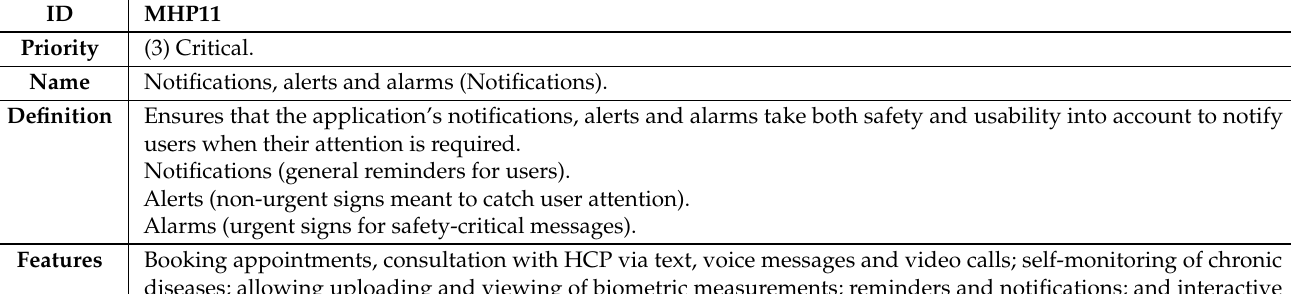
Table A11. Descriptive details of the eleventh guideline.